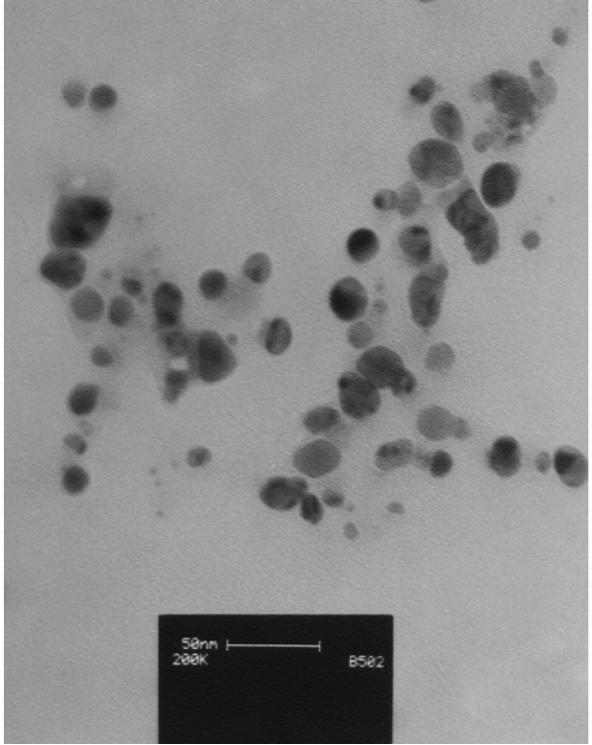
Figure 7: TEM image of the synthesized AgNPs at obtained optimum